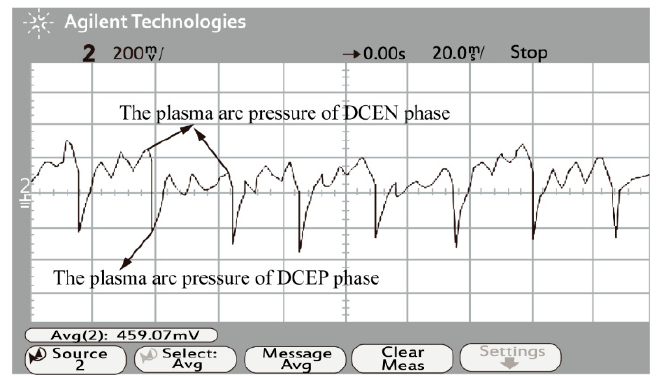
Figure 11. Sketch of the arc pressure waveform.